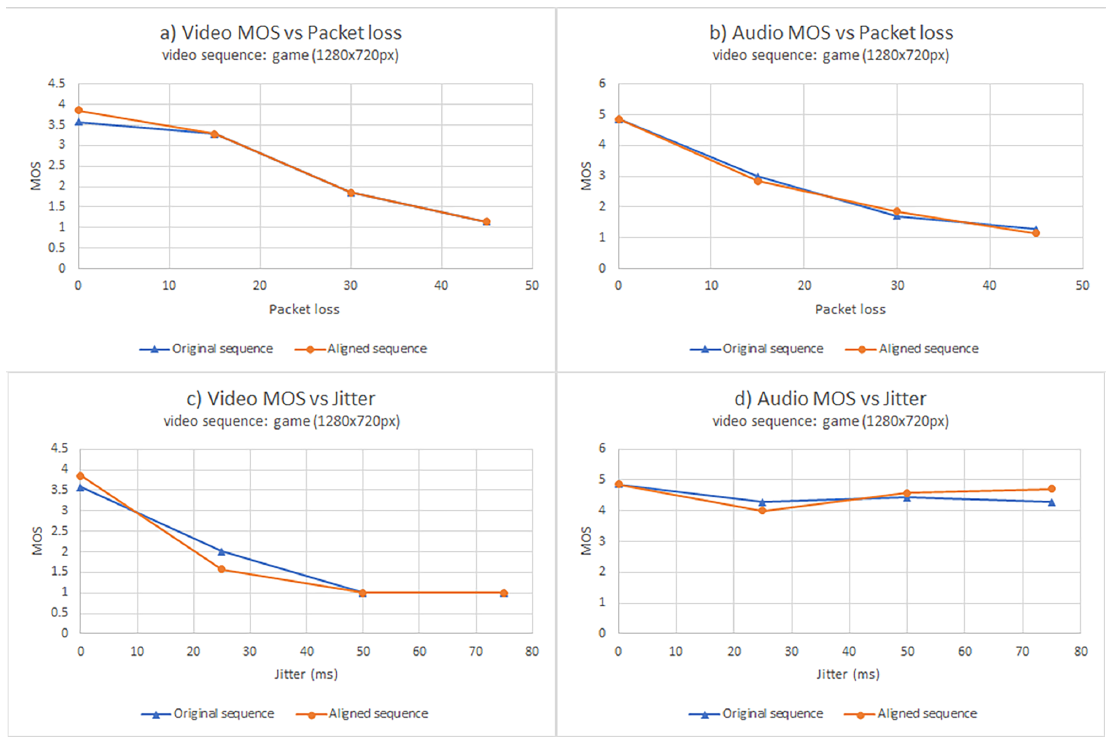
Figure 8. Comparison of the subjective results in the pilot for the game sequence. ( a ) Video quality using different scenarios of packet loss. ( b ) Audio quality using different scenarios of packet